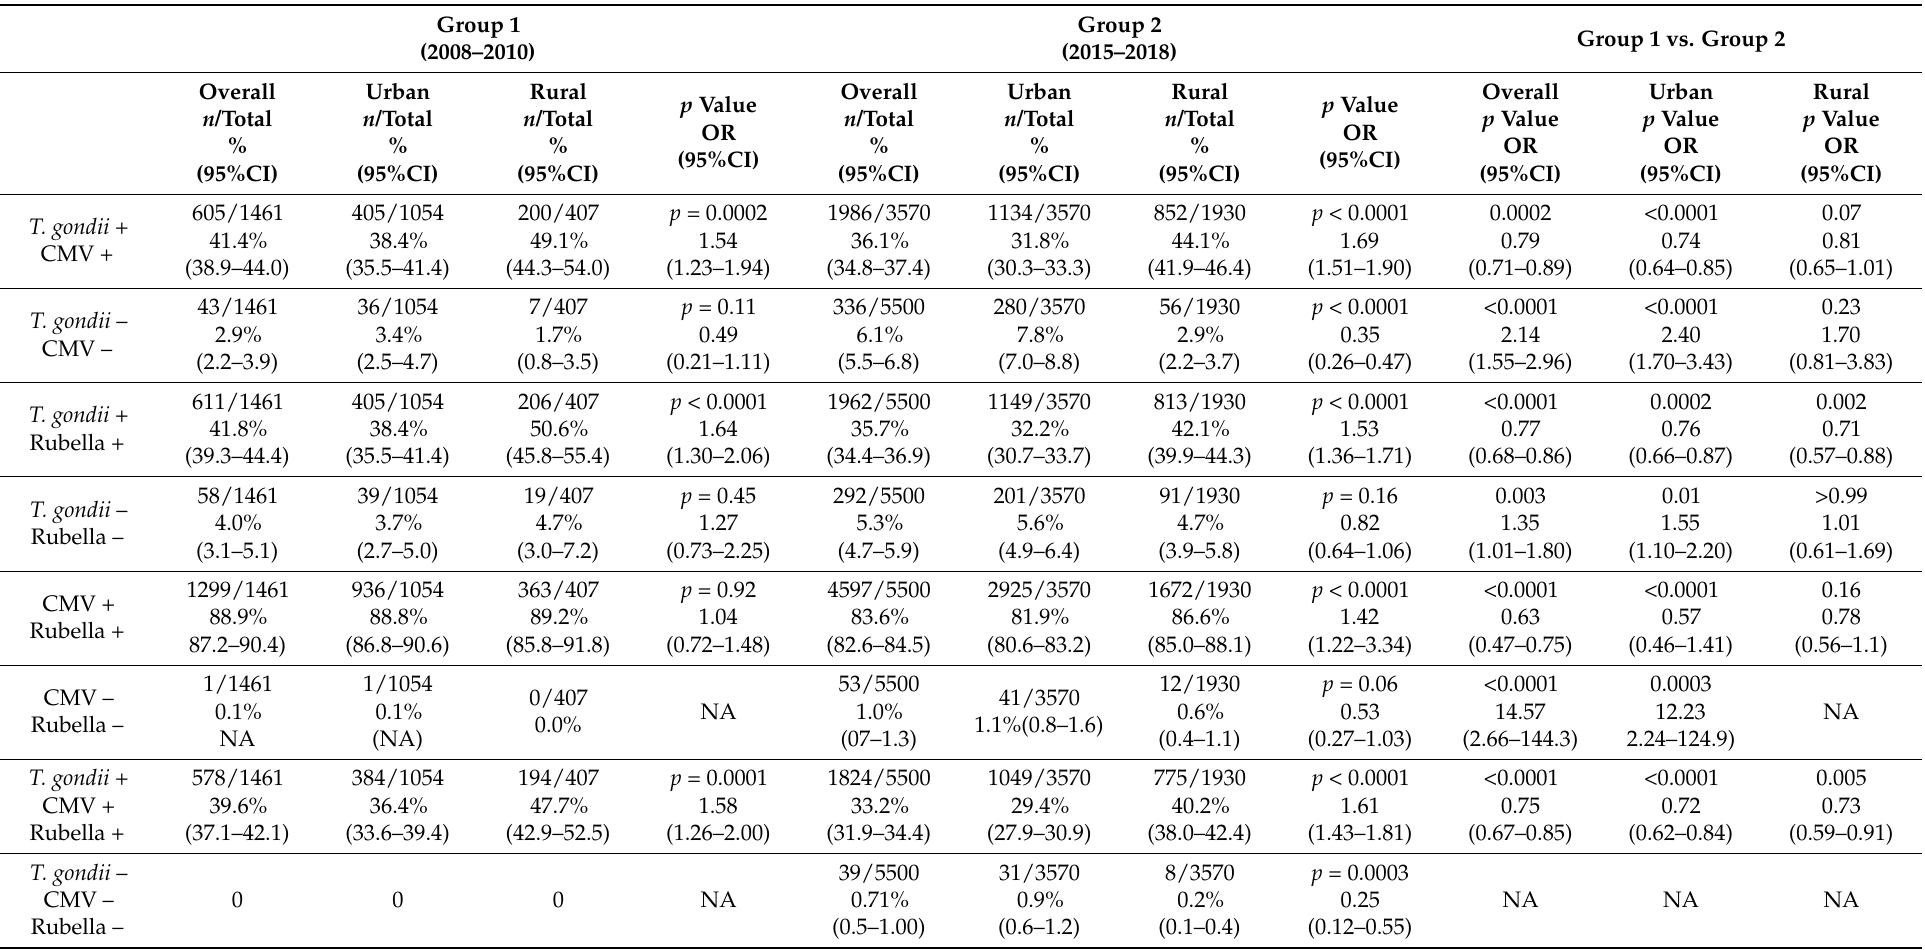
Table 4. Rate of women with simultaneous positive IgG-anti- Toxoplasma gondii, -CMV and -rubella virus antibodies according to the place of residence (2008–2010 vs.